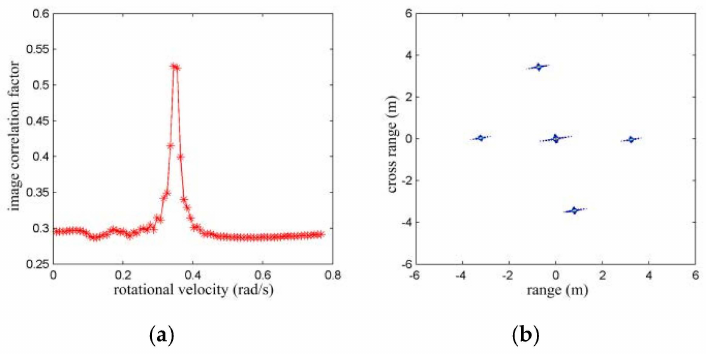
Figure 4. RV estimation for accelerated rotating object with isolated scattering model. ( a ) Correlation coefficients with different RV; and ( b ) range and cross-range scaled image with the estimated RV by image rotation correlation